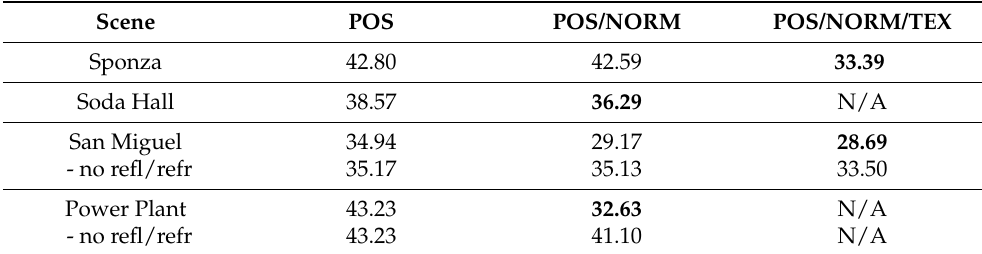
Table 4. Image quality comparison (PSNR in dB). The ray-traced images from the quantized meshes are compared to the ground truth images obtained by ray tracing the original meshes, where three combinations of quantizations are examined. The “- no refl/refr” row indicates the PSNR values achieved when the images are produced with the reflection/refraction feature off. All images are rendered at 1024 × 1024 pixels. See Figure 2 for the adopted camera views. Scene POS POS/NORM